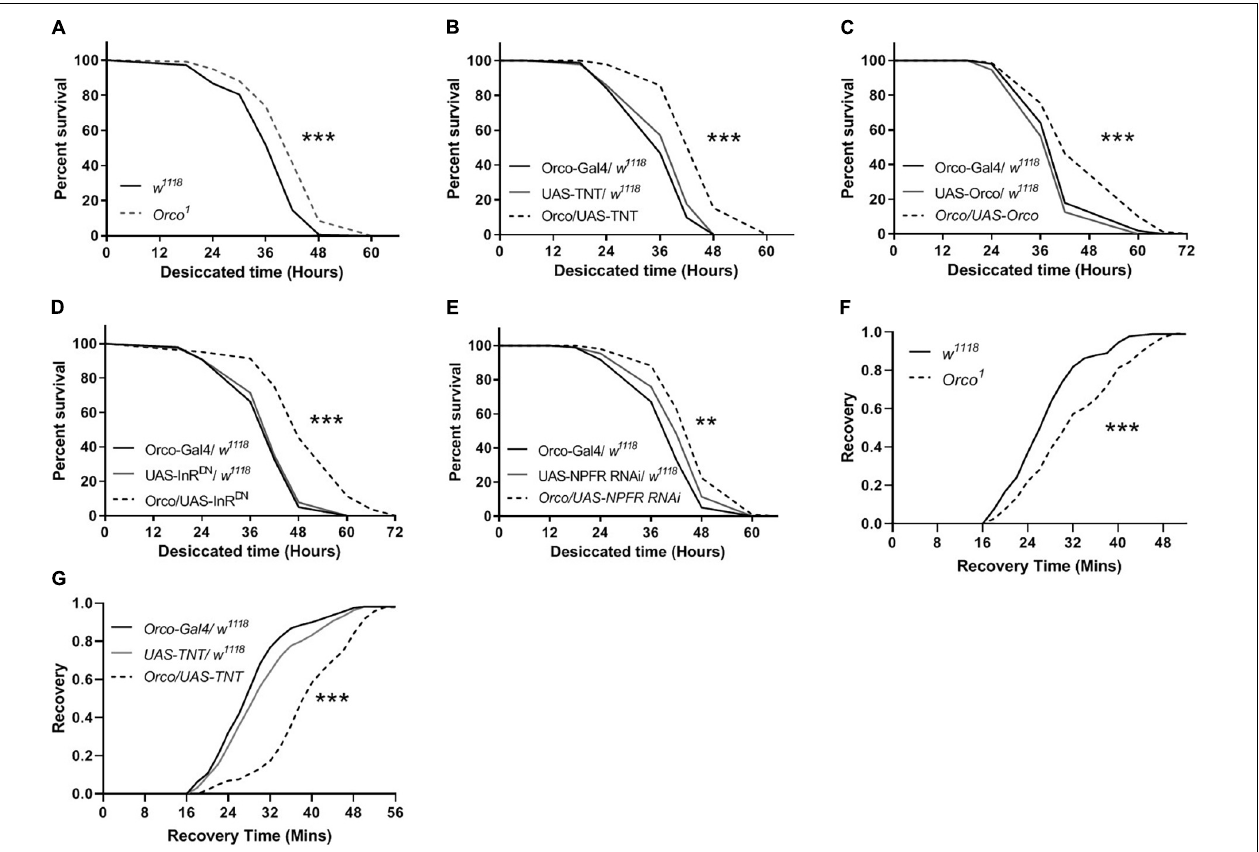
FIGURE 7 | OSNs mediate desiccation and cold resistances. The survival lifespan under desiccated condition was extended in Orco 1 mutant flies (A) , after expressing TNT in OSNs (B) , after expressing Orco in OSNs (C) ( n = 9–10 vials/group). Decreasing InR activity (D) or decreasing NPFR level (E) in OSNs enhanced the desiccation resistance ( n = 8–9). The recovery time after cold stimulation was extended in Orco 1 mutant flies (F) , or after expressing TNT in OSNs (G) ( n = 9–12). Log-rank (Mantel-Cox) test were used to determine the significant differences. ** p < 0.01 and *** p <